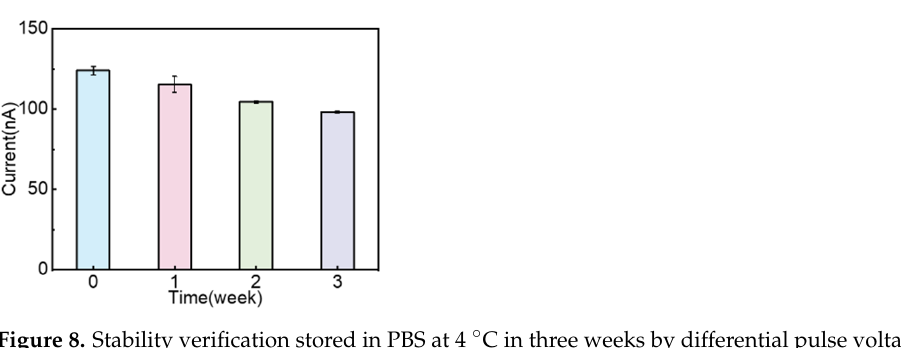
( e ) Figure 9. The characterization of exosome. ( a ) TEM image and ( b ) ZetaView analysis of the size distribution of extracted exosomes derived by H1395 cells; ( c ) Under 549 nm laser excitation, red fluorescence represents antibodies, ( d ) Under 488 nm laser excitation, green fluorescence represents exosomes, ( e ) Merged picture of ( c , d ).